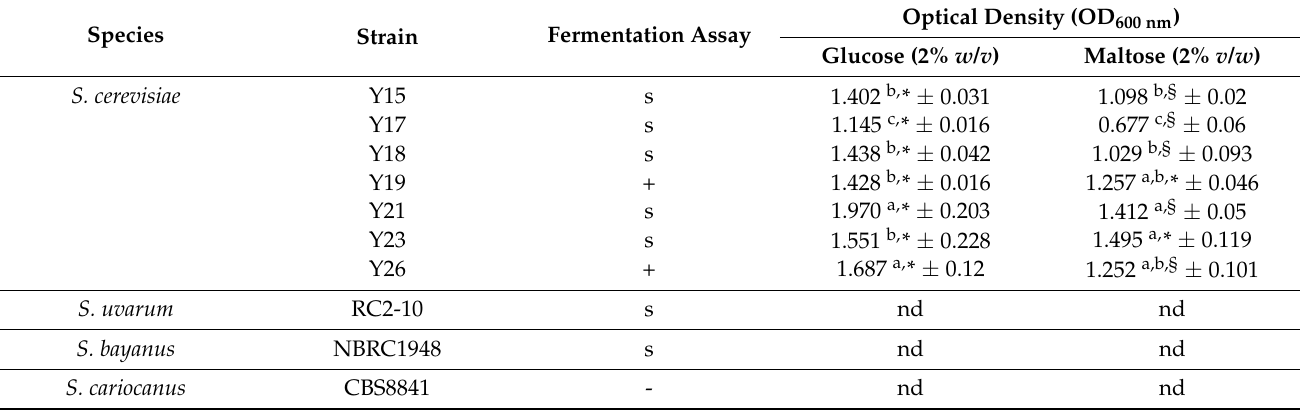
Table 2. Maltose consumption tests. The results of fermentation tests are scored according to Kurtzman et al. [50] as follows: +, strongly positive; s, slowly positive; -, no gas production. Optical density at 600 nm (OD 600 nm ) was evaluated after 48 h of fermentation in medium containing either glucose or maltose. Different superscript letters indicate significant differences ( p < 0.05) in the same column, while different symbols (* and §) indicate significant differences in the same raw, as determined by ANOVA followed by Tukey HSD test. Superscript letters were attributed as follows: the highest value was marked as “a,” the next value that is significantly different can be “b,” and so on. Abbreviation: nd, not determined.